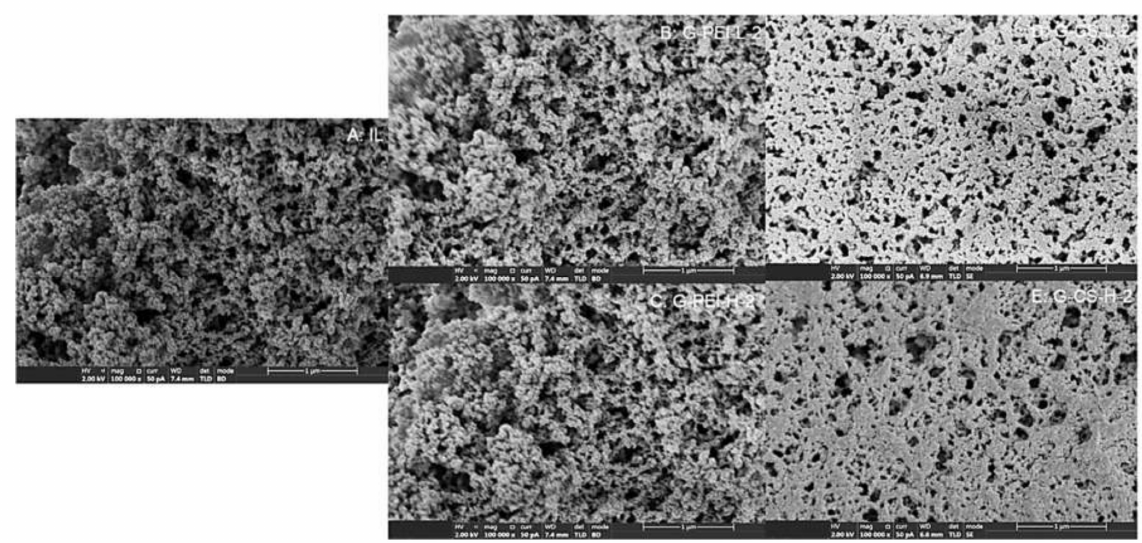
Figure 6. SEM micrographs of immobilized lipase with different modifications. Physical adsorption ( A ); chemically crosslinking with PEI-L ( B ) and PEI-H ( C ); chemically crosslinking with CS-L ( D ) and CS-H ( E ).